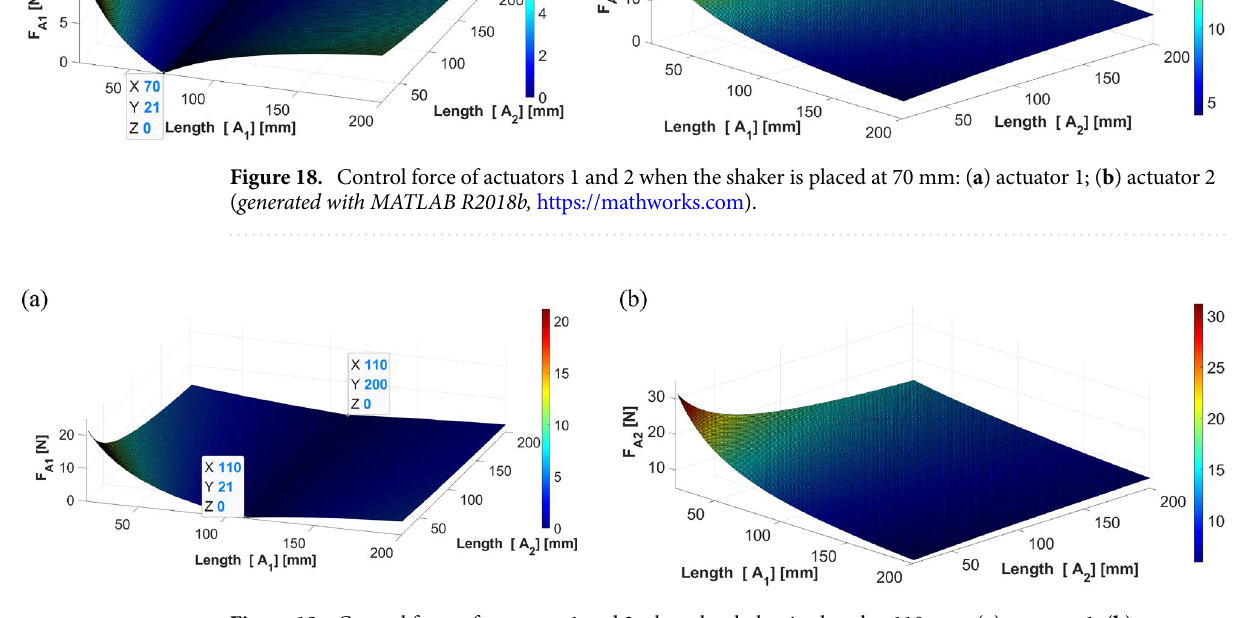
Figure 19. Control force of actuators 1 and 2 when the shaker is placed at 110 mm: ( a ) actuator 1; ( b ) actuator 2 ( generated with MATLAB R2018b, https:// mathw orks.